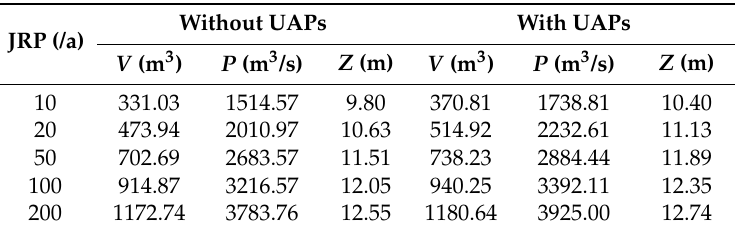
Table 4. Design value for flood characteristics.